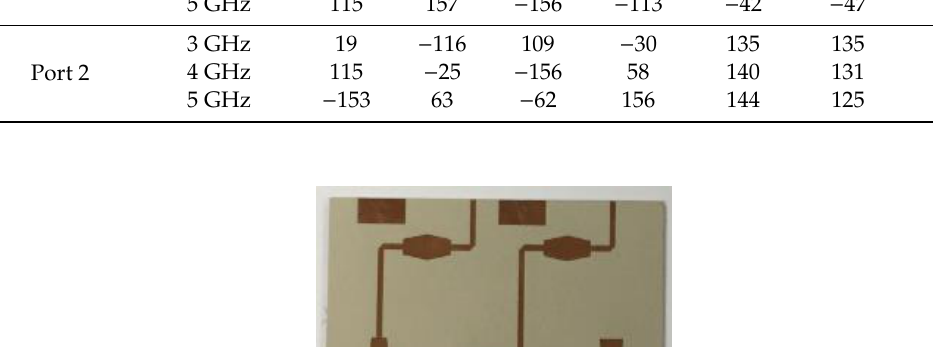
Figure 22. Group delay analysis of the proposed 4 × 4 Butler matrix ( a ) results of output ports for